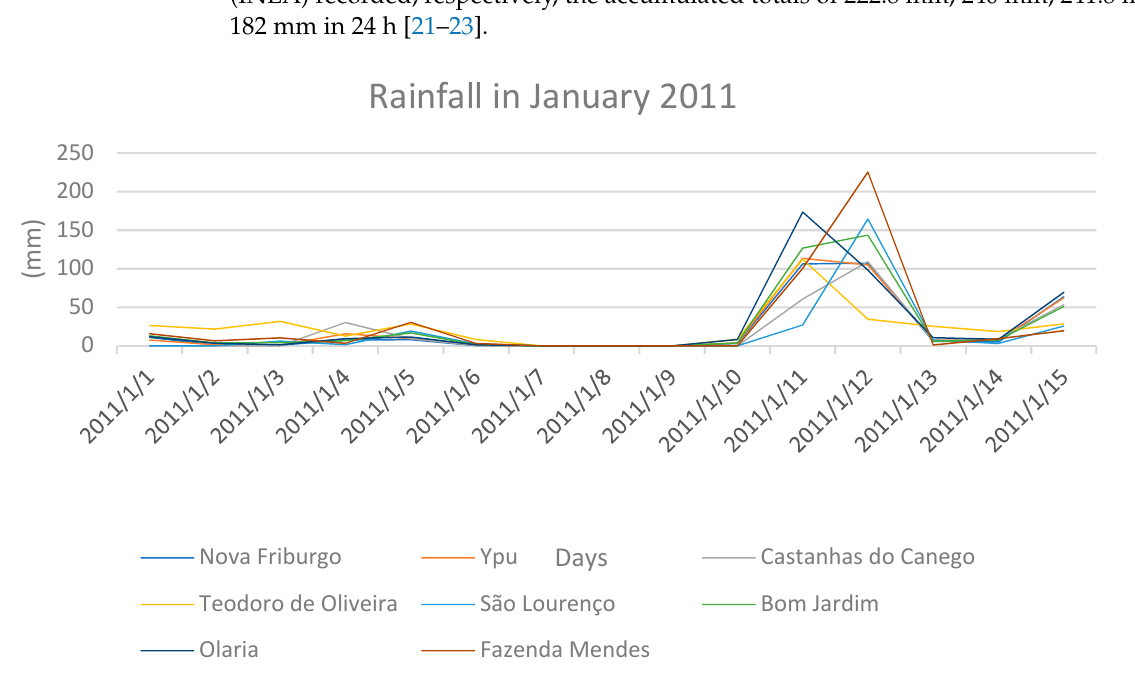
Figure 3. Daily precipitation at the stations in the Upper Rio Grande Basin, RJ.